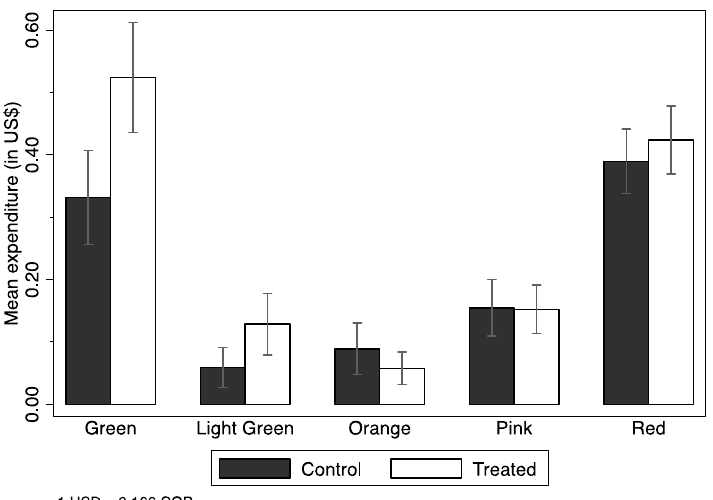
Figure 4. Unconditional mean expenditure of items per purchase, by Nutri-Score classification, of treated and control groups.